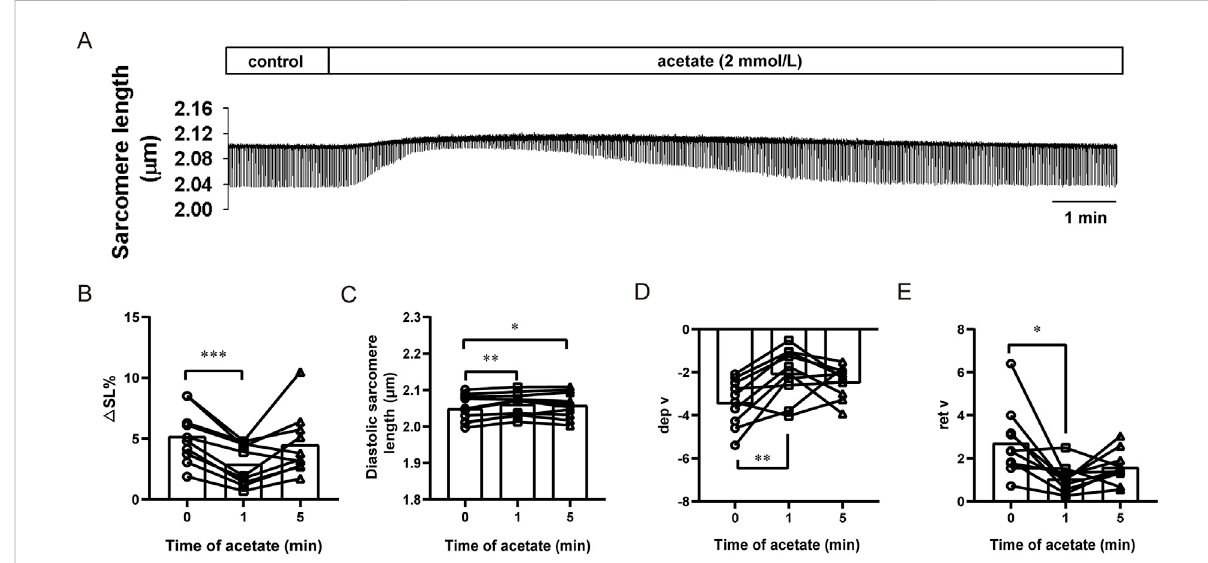
FIGURE 3 Acetate inhibited contractility in isolated myocardial cells. Representative traces of myocardial contraction (A) . The sarcomere contraction amplitude (B) , diastolic sarcomere length (C) , maximum contraction velocity (D) , and maximum relaxation velocity (E) in isolated myocardial cells. N = 5, n = 10. N: the number of rats, n: the number of cells. * p < 0.05, ** p < 0.01, *** p <